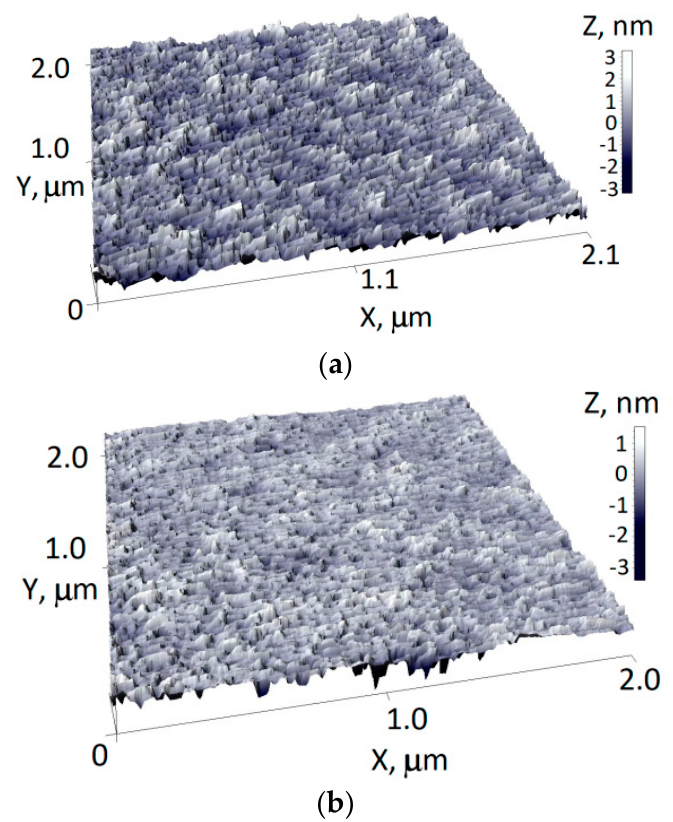
Figure 3. Surface topography of the 10 nm gold layer, obtained by single deposition ( a ) and by the single application of a repeated deposition ( b